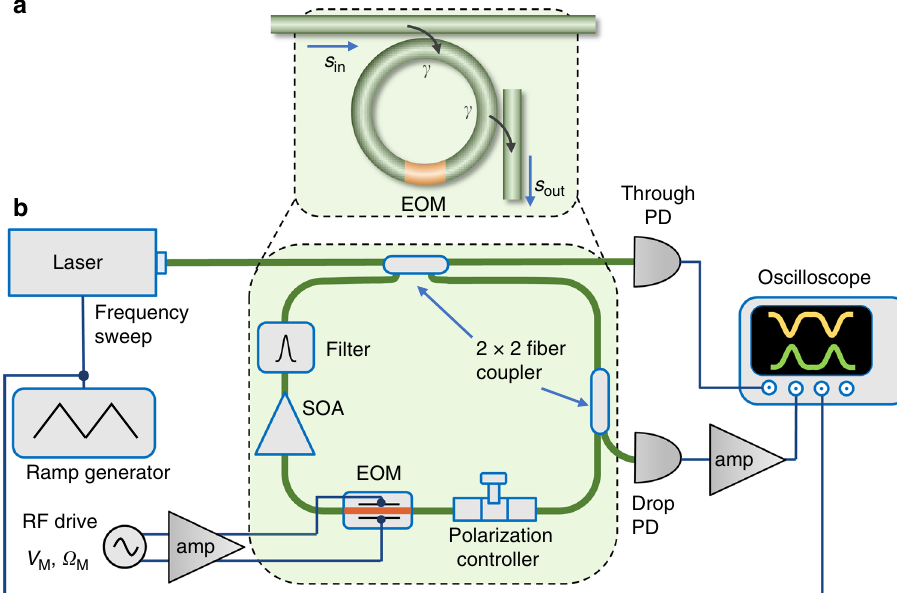
Fig. 2 Experimental setup. a Schematic. b Detailed setup. Cavity length ~13.5 m, Cavity mode spacing or free-spectral range Ω R = 2 π ⋅ 15.04 MHz. EOM electro-optic phase modulator, PD photodiode, SOA semiconductor optical ampli fi er, amp RF ampli fi